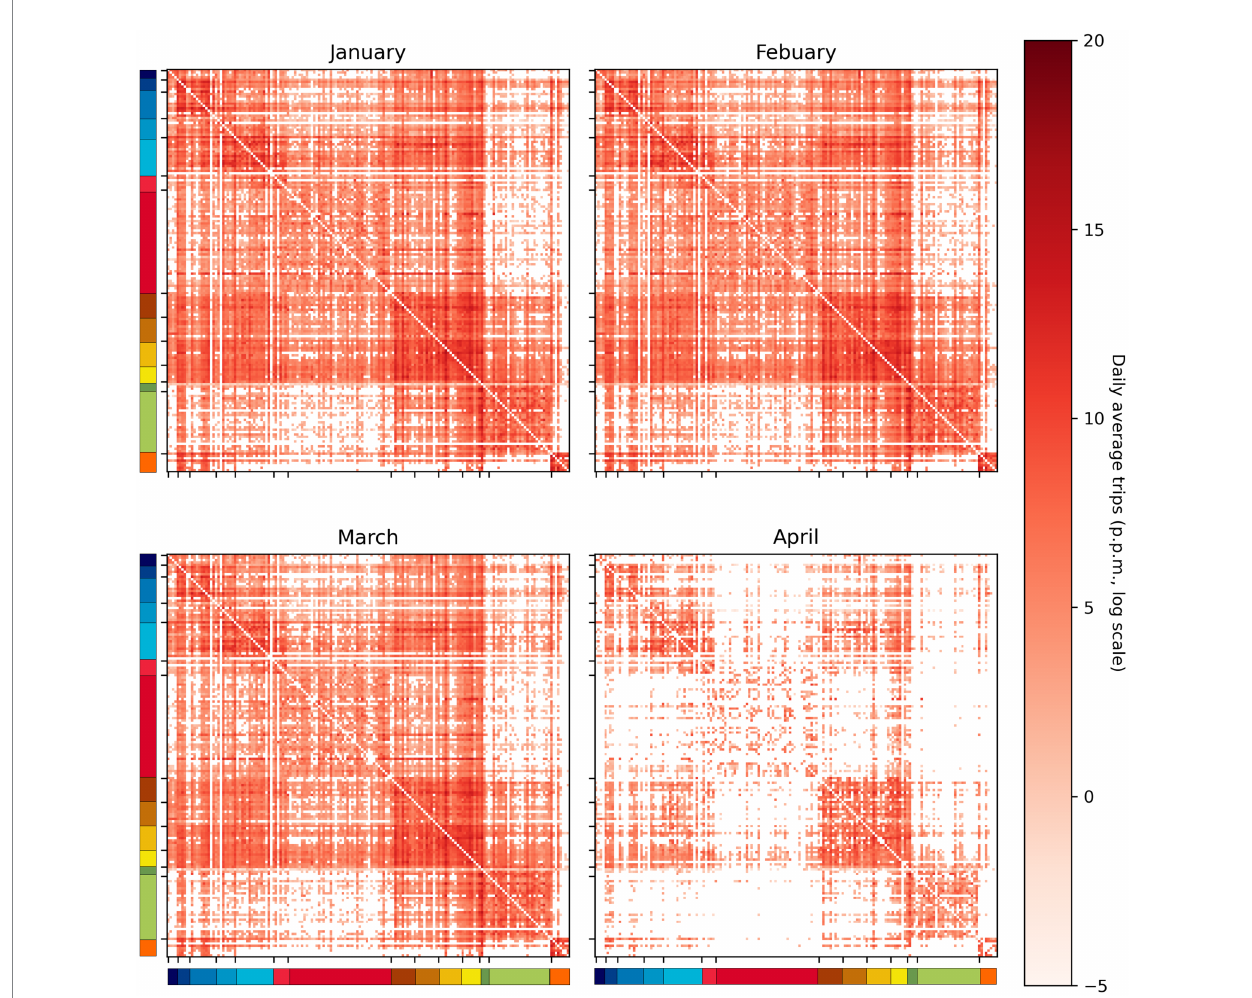
FIGURE 2 Country-to-country daily average trip number. The color bars on the left and bottom sides indicate the continent to which each country belongs.